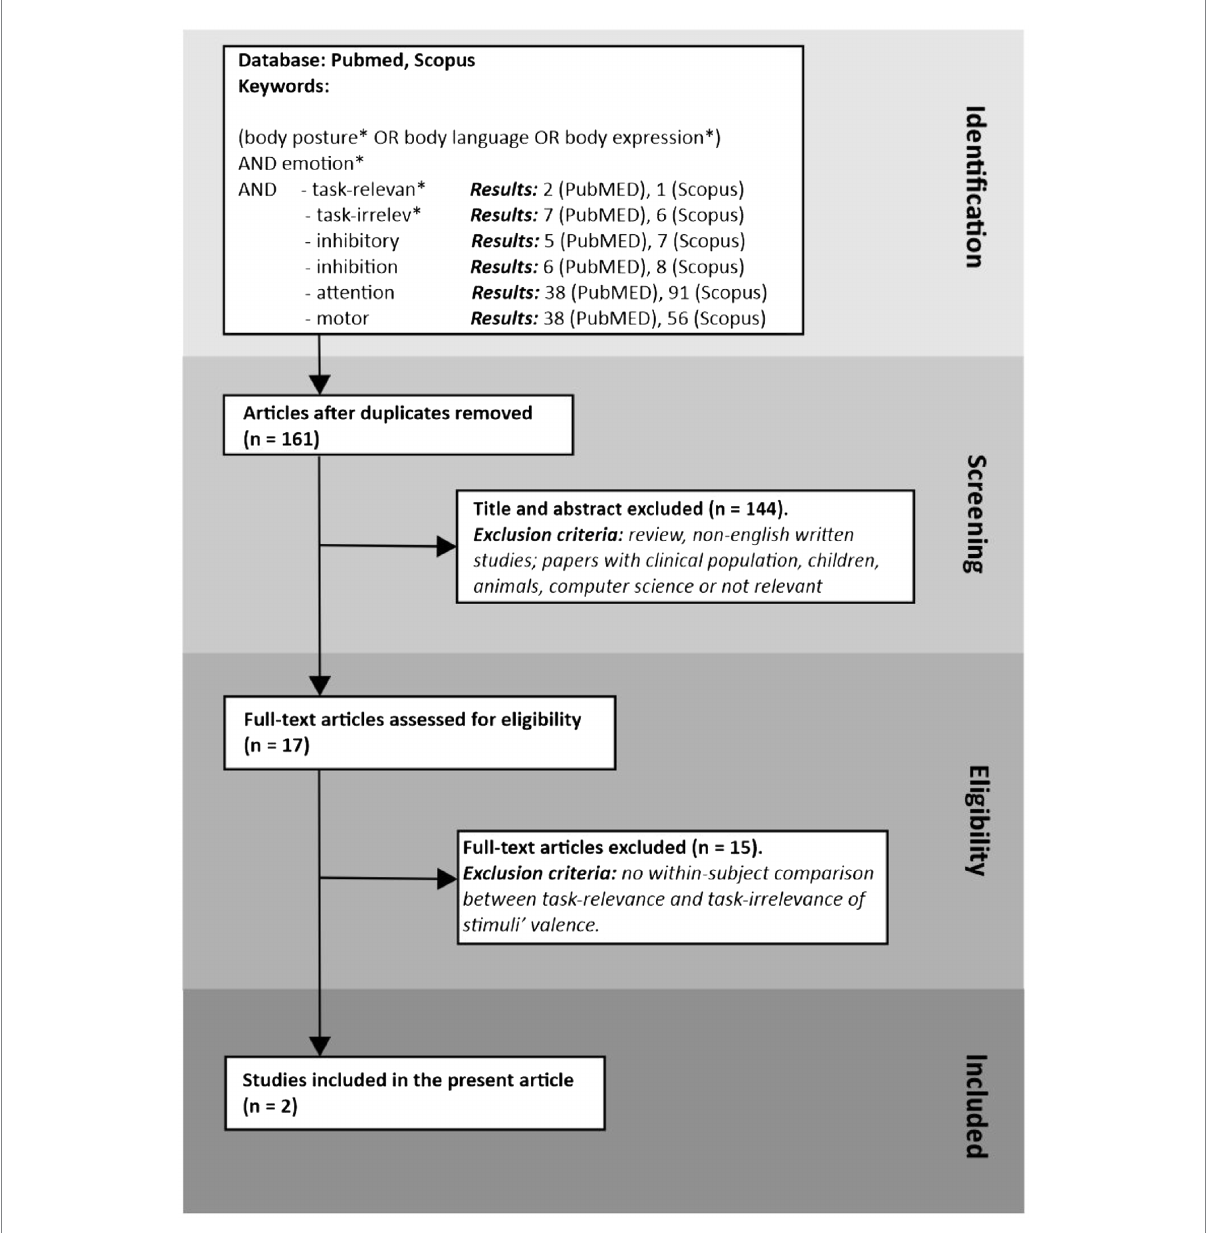
FIGURE 1 Flow charts of two systematic review procedures using PubMed (pubmed.ncbi.nlm.nih.gov/) on March 24, 2022, and Scopus (www.scopus.com/) on March 25, 2022. Separately on the two databases, we performed six different searches using keywords to be found in the titles or abstracts.